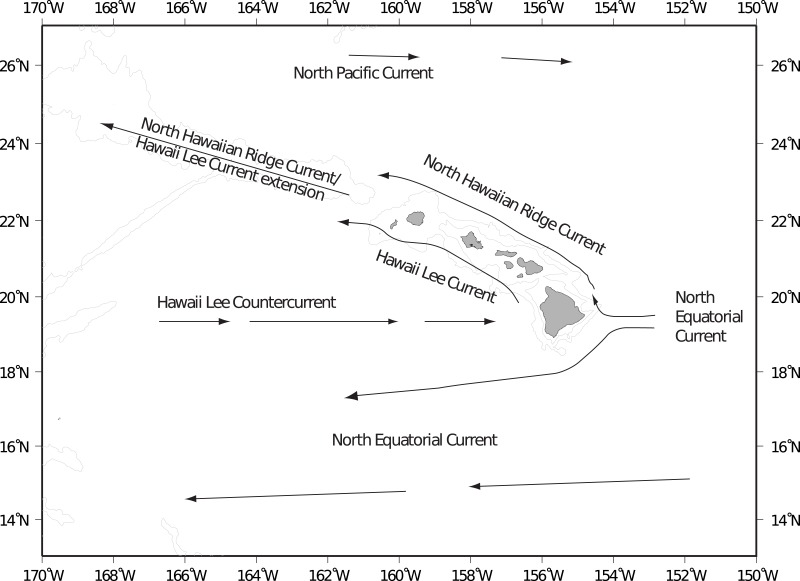
Main surface currents around Hawaii.Main surface currents around the Main Hawaiian Islands (after Lumpkin, 1998).